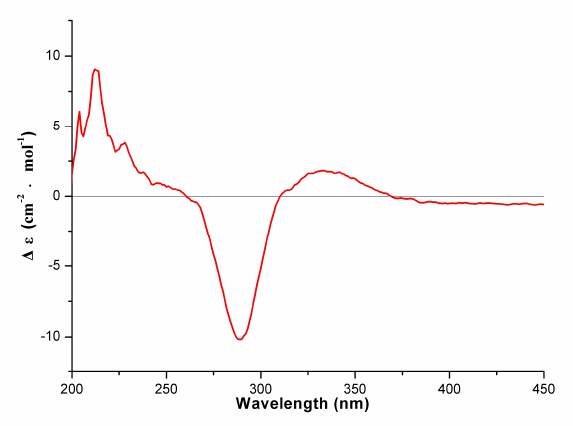
Figure 4. CD spectrum of compound 4 (in MeOH).